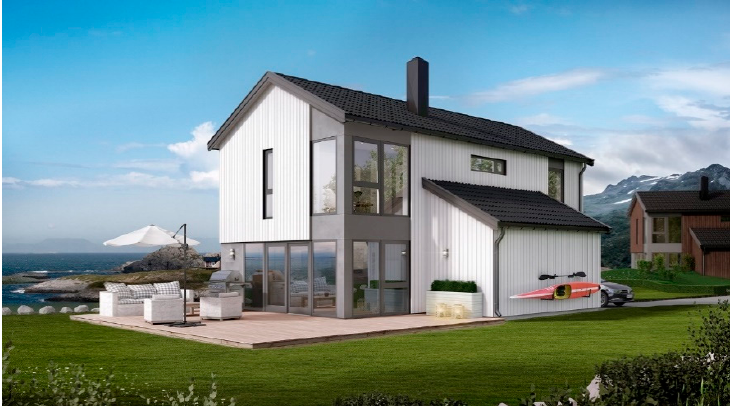
Figure 2. Typical residential building in Norway (Source: Norgeshus).